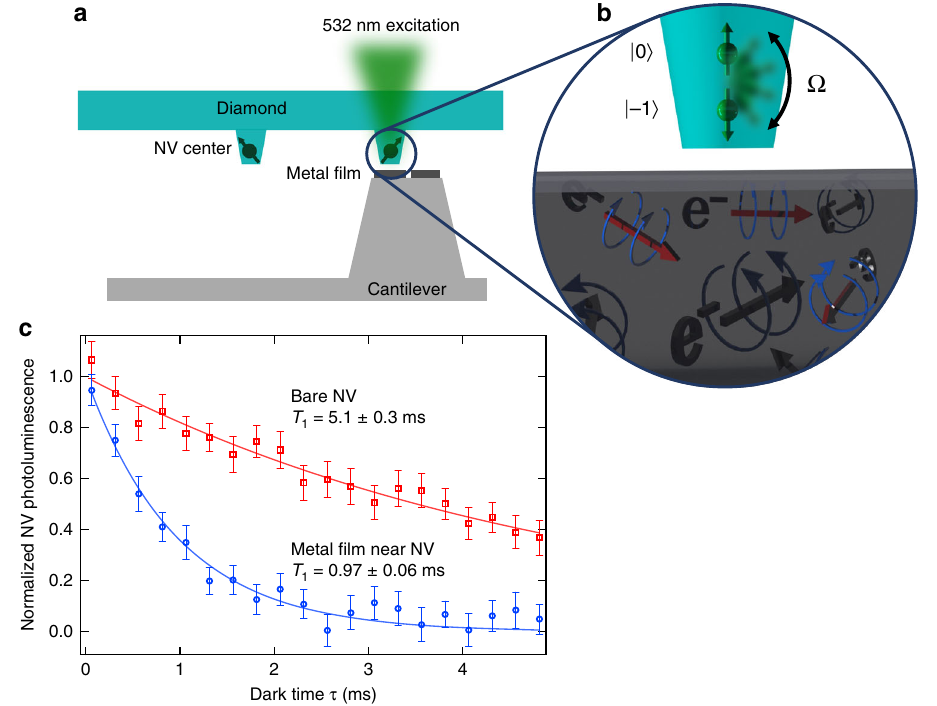
Fig. 1 Conductivity imaging using the nitrogen-vacancy (NV) center. a A metallic sample is deposited onto the fl at tip of an in-house-fabricated silicon scanning probe. The fl at plateau region is several micrometers in diameter. This ‘ sample on tip ’ is scanned over a diamond pillar containing a single-NV center. 532 nm excitation is used for optical control and readout of the NV spin triplet. b Illustration demonstrating NV spin relaxation in the presence of a conductor. The stochastic, thermal motion of free electrons produces magnetic fl uctuations that increase the spin transition rate Ω between | m s = 0 〉 and | m s = − 1 〉 , detectable as a reduction of the NV center ’ s spin relaxation time T 1 . c Measurement of the T 1 of an NV center far from any conductor (red squares) and positioned 100 nm above the surface of an 85-nm thick Ag fi lm (blue circles). The speci fi c measurement sequence is discussed in the main text and yields an exponential photoluminescence decay exp( − τ / T 1 ) with T 1 = 1/3 Ω . The presence of the Ag fi lm reduces the NV T 1 fi vefold. Error bars correspond to measured standard